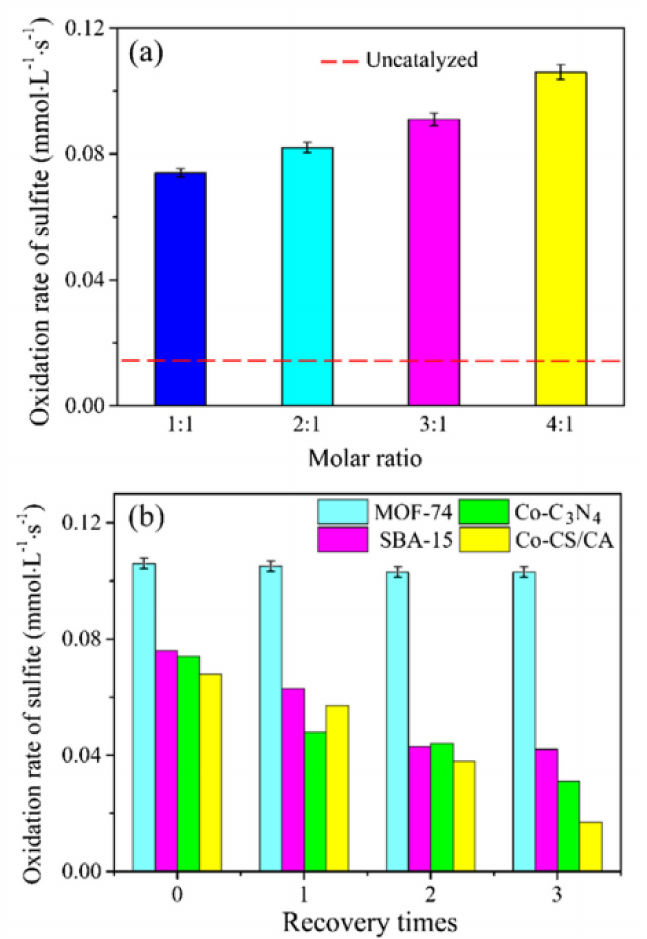
Figure 14. ( a ) Sulfite oxidation rate under catalysis by Co–MOF-74 with different cobalt/ligand ratios; ( b ) recovery rate comparison chart of Co–MOF-74, CoSBA-15, Co–C 3 N 4 , and Co–CS/CA catalysts. Reproduced with permission from